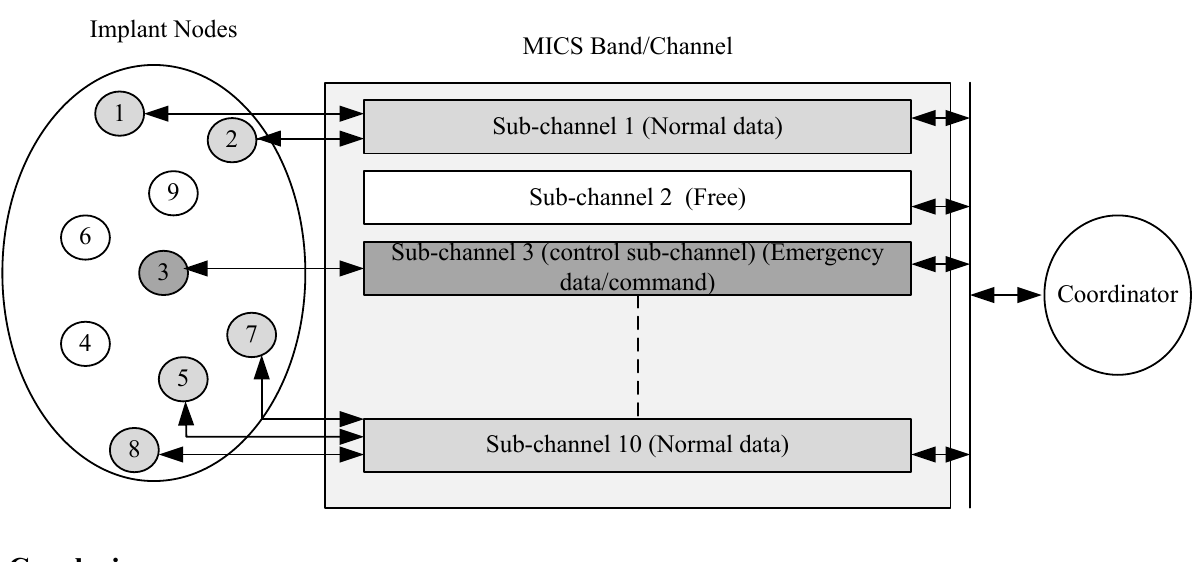
Figure 8. An example of a control sub-channel for emergency